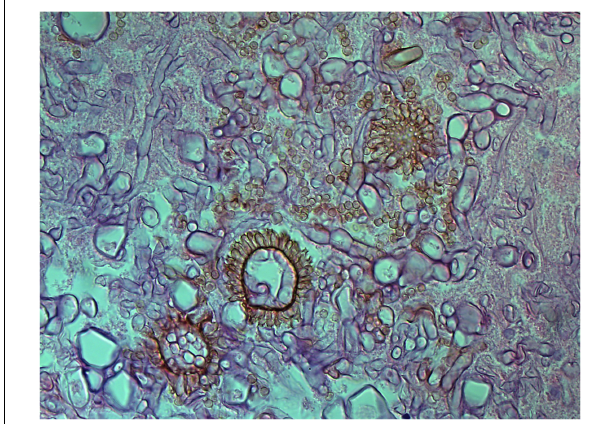
FIGURE 6 | “Extranodal natural killer/T-cell lymphoma, nasal type-orbital-cerebral mycosis.” Distorted, broken, and disintegrated hyphae of Mucor irregularis (H&E, original magnification × 400).